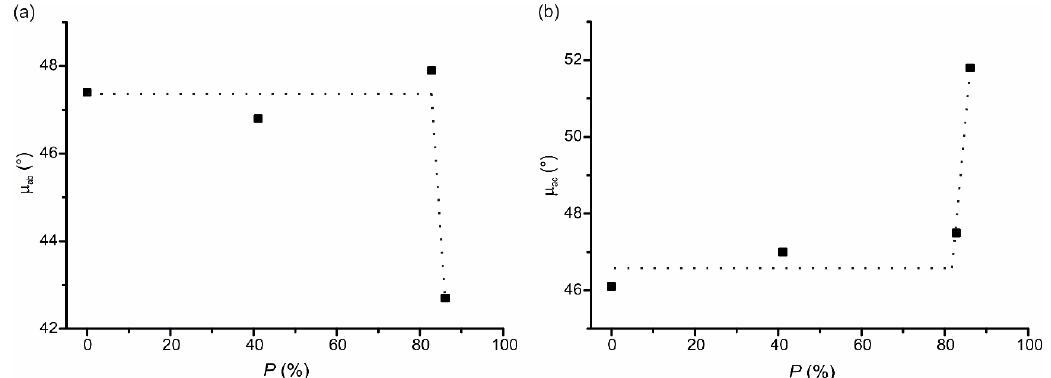
Figure 5. Changes in the angle between the best plane of the anthracene moiety and ( a ) the ab plane and ( b ) the ac plane at 0.3 GPa. For the bc plane the molecular orientation is statistically constant and ca. 90° (not shown in the figure). Similar relationships are also observed for 1.0 GPa.